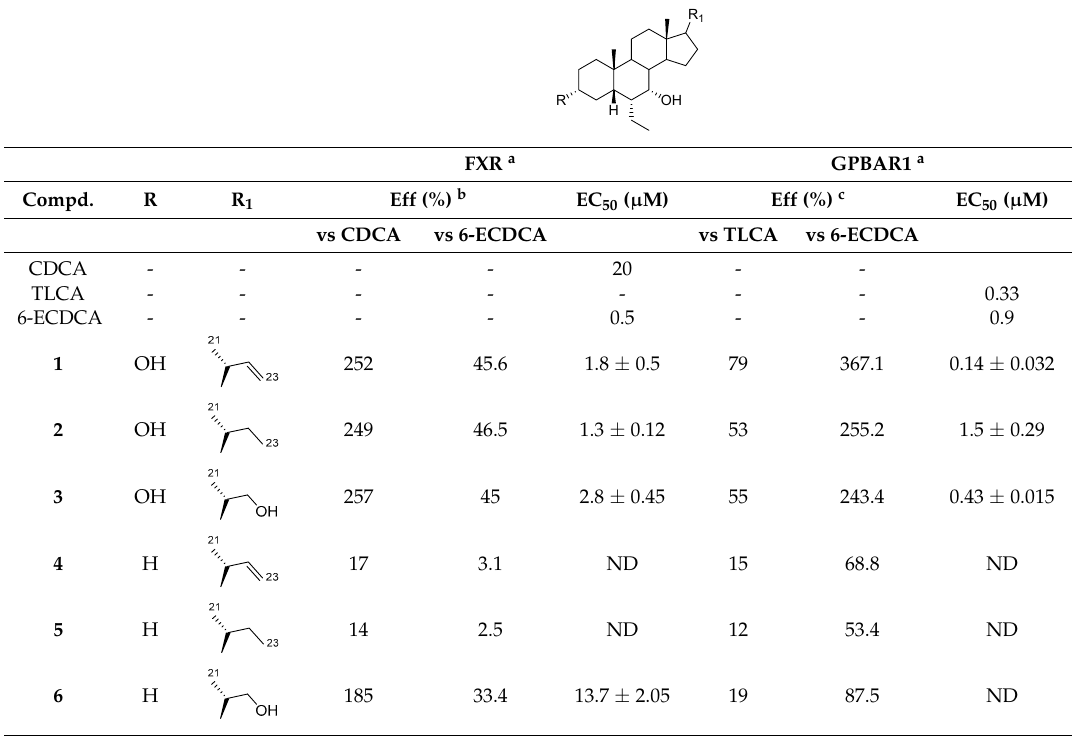
Table 1. Efficacy and potency for compounds 1 – 6 .